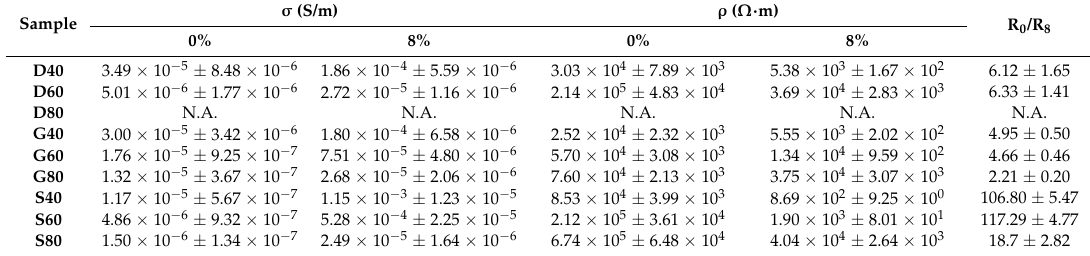
Table 2. Electrical conductivity of TPU/GE composites as a function of porosity and internal morphology.